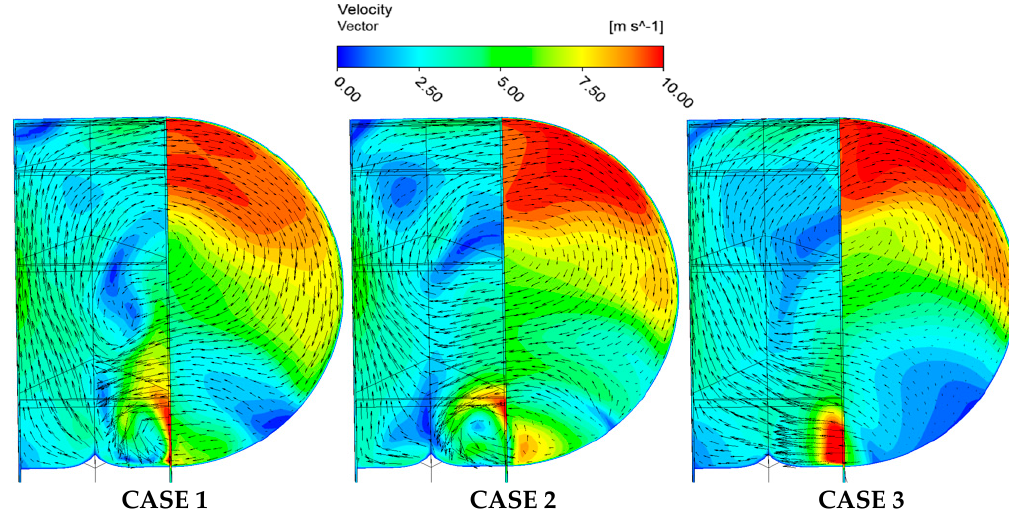
Figure 12. Velocity vector distribution in impeller and side channel.